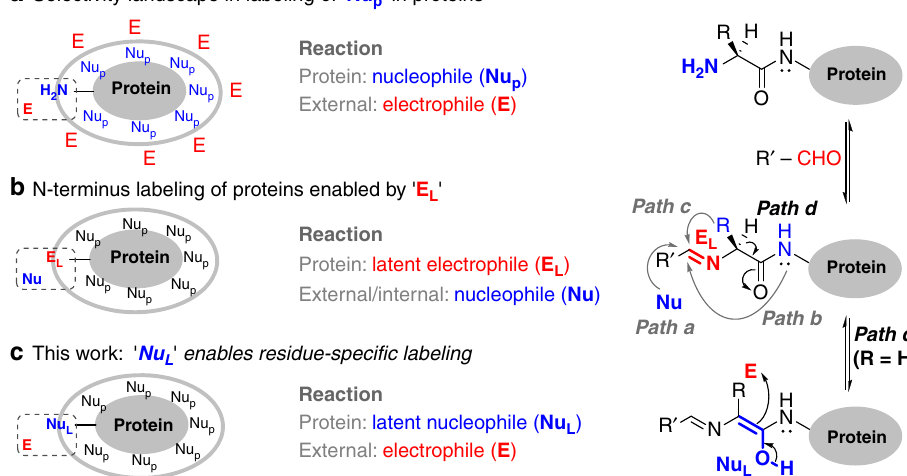
Fig. 1 Residue-speci fi city in labeling of proteins. a Nucleophilic addition of protein residues to an electrophile. b A latent electrophile, imine, renders the N-terminus labeling of proteins (path a – path c). c Latent nucleophile enables single-site N-terminus Gly